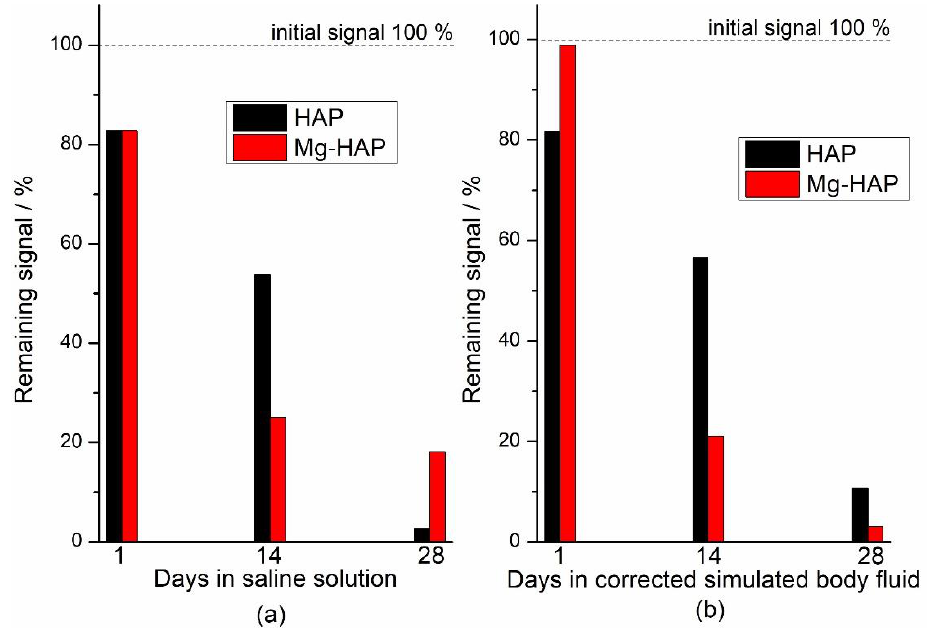
Figure 5. Dependence of double integral of the signal on the number of days of immersion ( a ) cor- rected simulated body fluid (c-SBF) and ( b ) saline solution (SS) at 37 °C of non-substituted hydrox- ( a ) corrected simulated body fluid (c-SBF) and ( b ) saline solution (SS) at 37 ◦ C of non-substituted yapatite (HAP) and Mg-substituted HAP (Mg-HAP) irradiated to 25 kGy. hydroxyapatite (HAP) and Mg-substituted HAP (Mg-HAP) irradiated to 25 kGy.